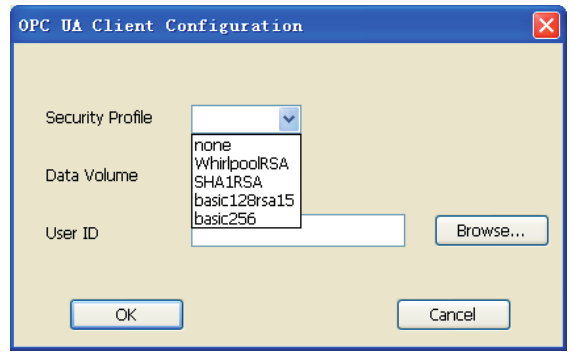
Figure 5. Program interface of client